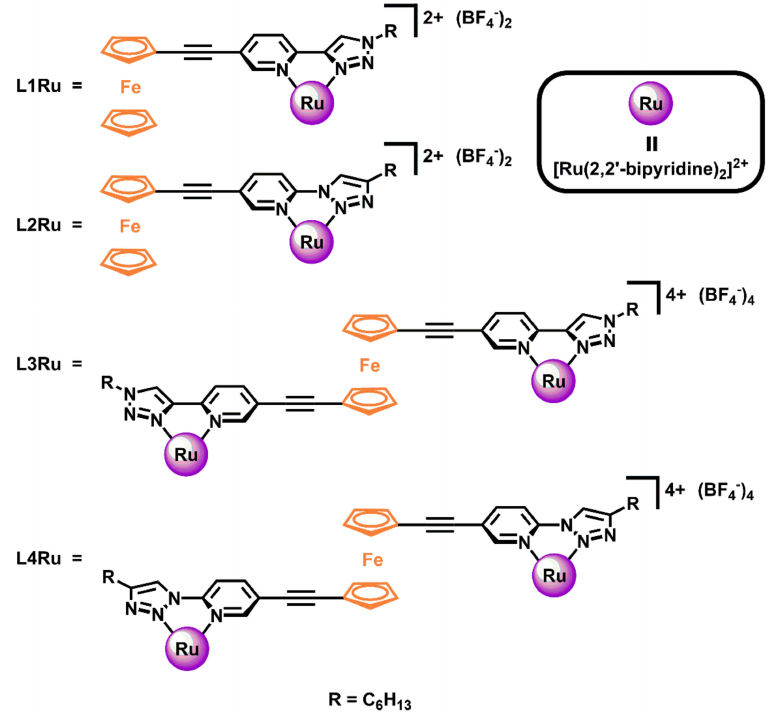
Figure 4. The molecular structures of the ruthenium complexes L1Ru – L4Ru .